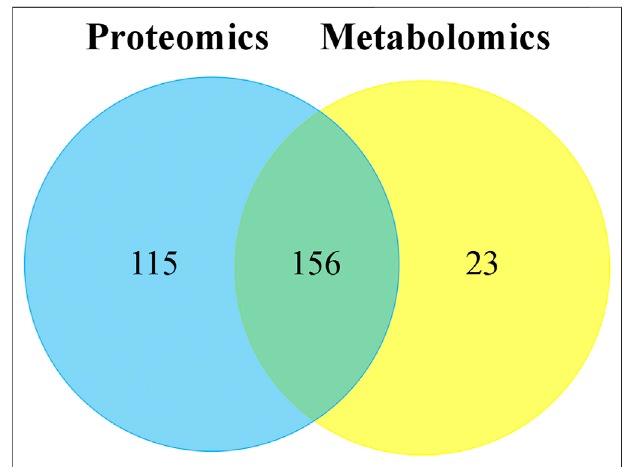
FIGURE 9 | The Venn plot of common pathways of DEPs and DEMs in MC and CPT groups. The blue and yellow circles represent proteomics and metabolomics, respectively. The overlap was the number of pathways shared by the two omics analyzes. The sum of all numbers in the circle represents the sum of the number of pathways involved in DEPs and